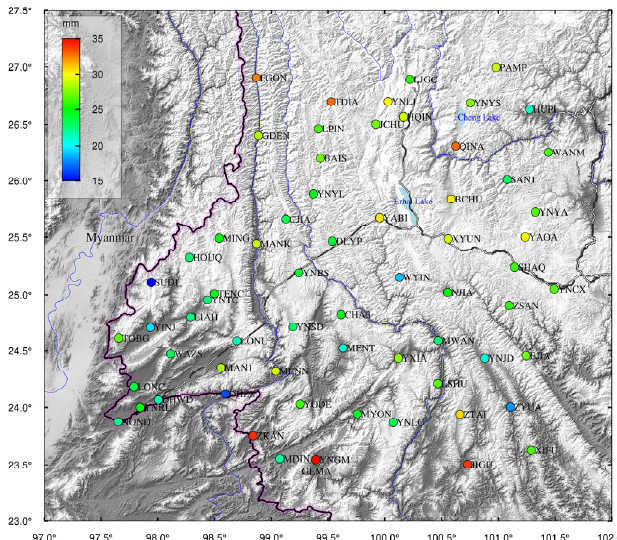
Figure 6. Range of the reconstructed geodetic heights at each CORS station in the study area.